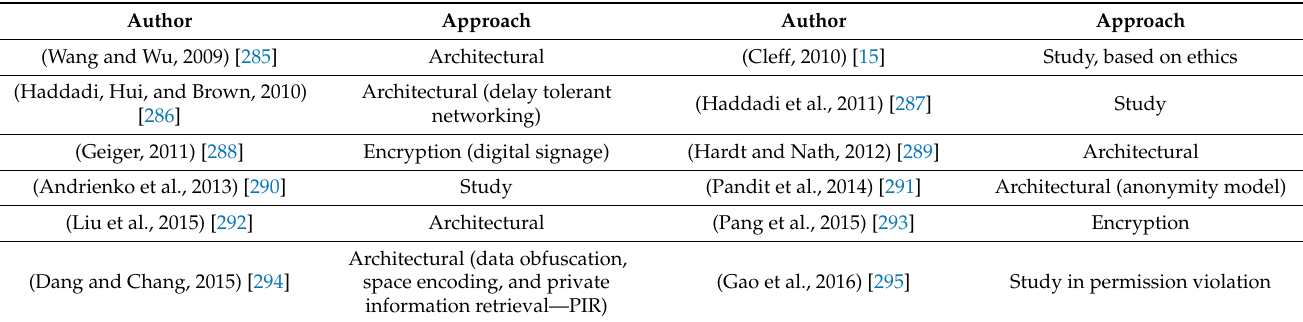
Table A5. Privacy-based